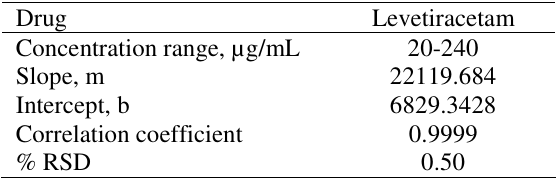
Table 1. Linear regression data for calibration